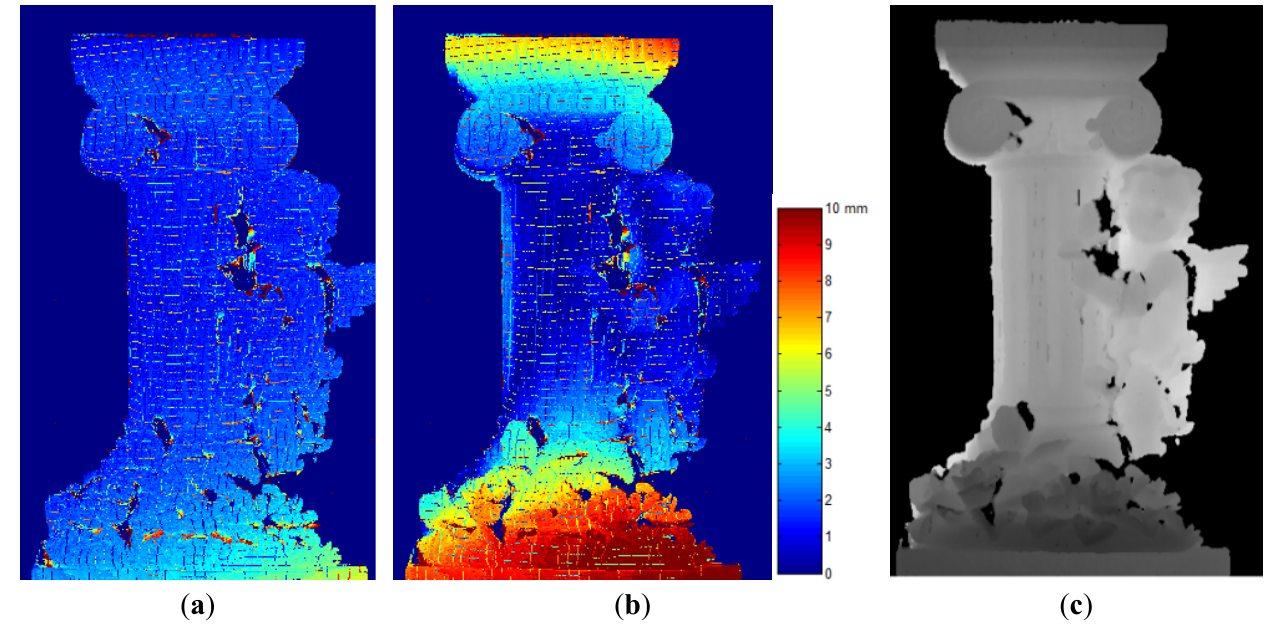
Figure 10. Triangulation error map of the parameters calibrated using